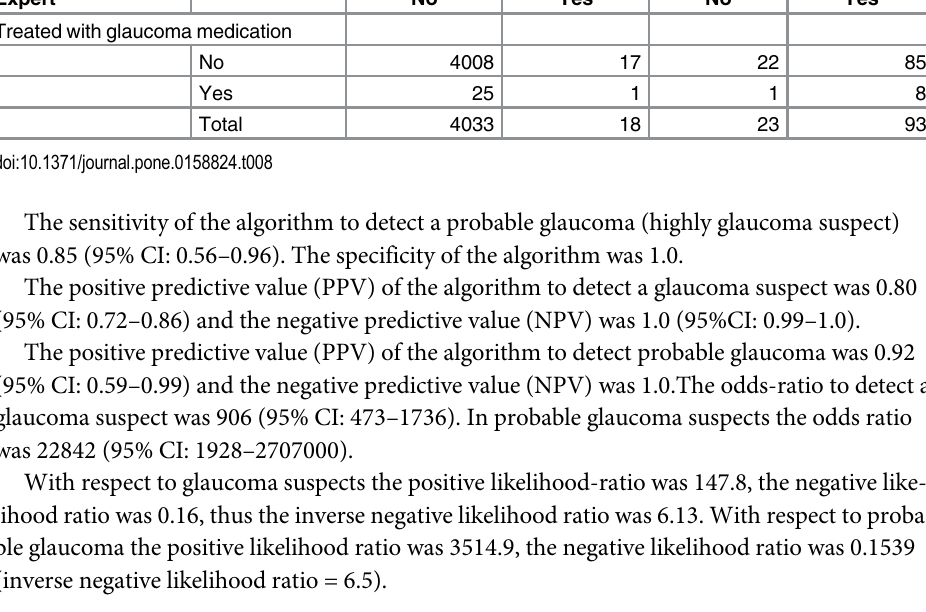
Table 8. Subjects treated with glaucoma medication and relation to the algorithm ’ s and to expert ’ s decision on the prevalence of glaucoma suspects.